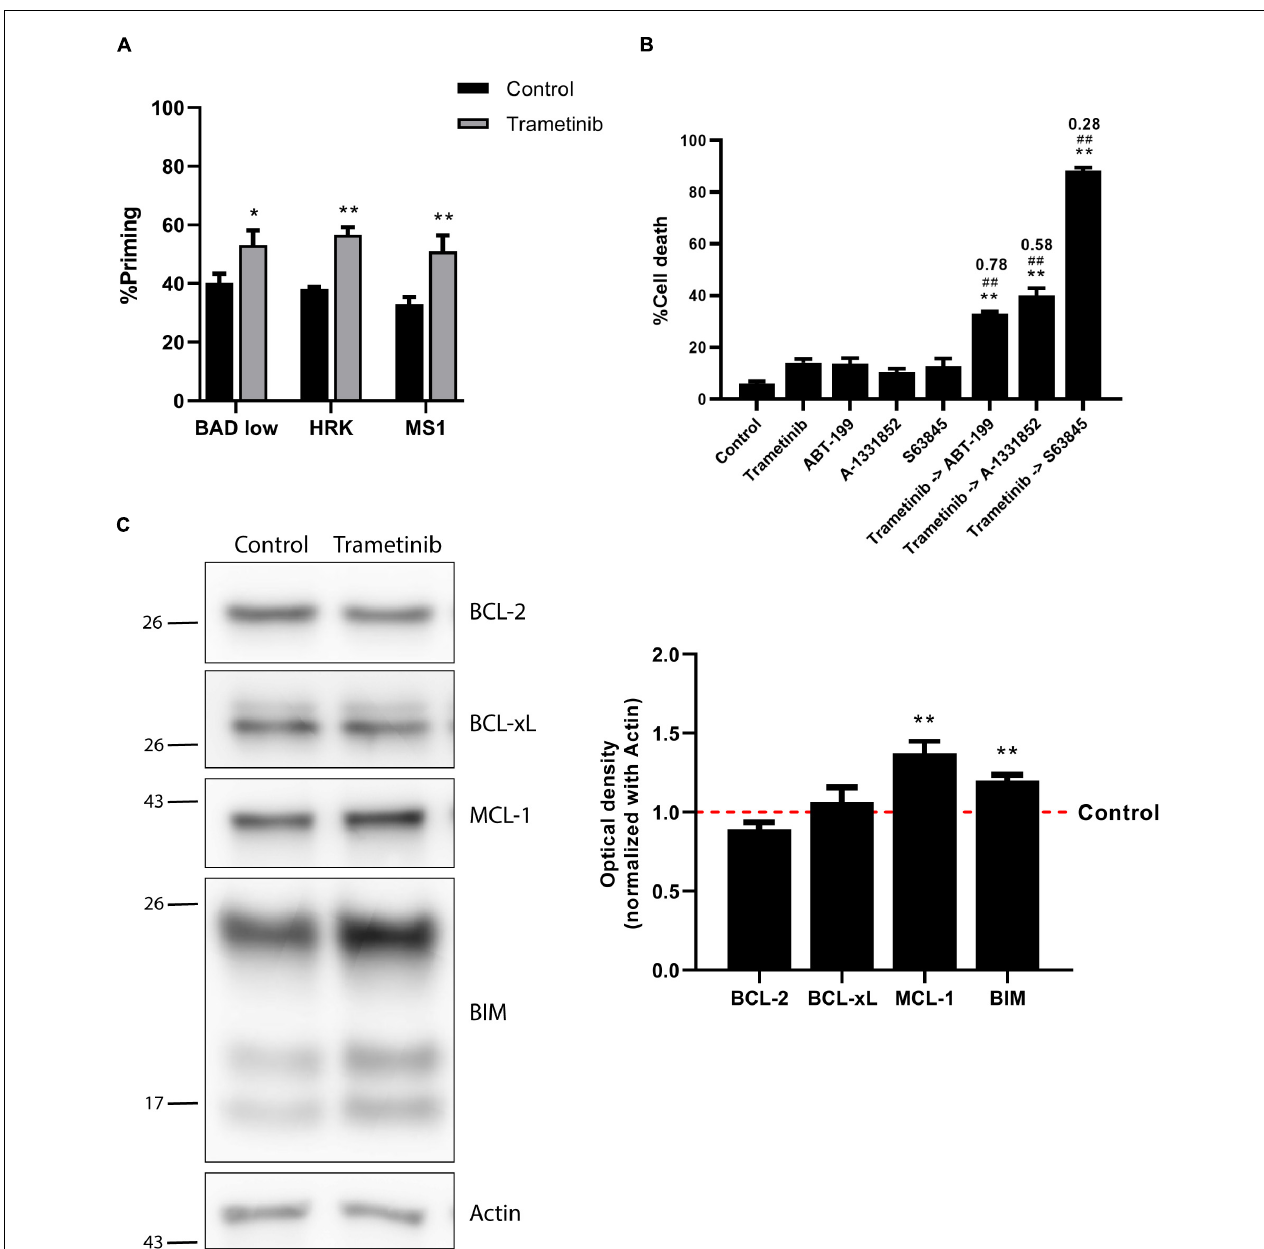
FIGURE 2 | Trametinib synergizes with S63845 in NALM-6 cells, increasing BIM and MCL-1 protein expression. (A) DBP results using sensitizer peptides to study anti-apoptotic dependence of BCL-2 and BCL-xL with BAD 0.1 µ M, BCL-xL with HRK 100 µ M and MCL-1 with MS1 10 µ M after 16 h of incubation with trametinib 100 nM in NALM-6 cell line. (B) Cytotoxicity was assessed by Annexin V/DAPI staining after 96 h incubation with trametinib 100 nM, ABT-199 100 nM, A-1331852 100 nM and S63845 1,000 nM in NALM-6 cell line. BH3 mimetics in combination with trametinib were added 16 h after treatment. (C) Western blot analysis for anti-apoptotic and BIM proteins in NALM-6 cells after 16 h of treatment with trametinib 100 nM. Quantification of optical density for each protein was normalized to actin, and fold-change was calculated comparing to protein expression in the control condition. All results are expressed as the mean ± standard error of the mean (SEM) of at least three biologically independent replicates. Statistical significance was calculated using Student’s t -test compared to control condition and considering * p < 0.05 and ** p < 0.01. Significance was also calculated comparing combination conditions with both single agents and considering # p < 0.05 and ## p < 0.01. Combination Index (CI) is indicated on top of every combination where CI < 1 indicates synergy.